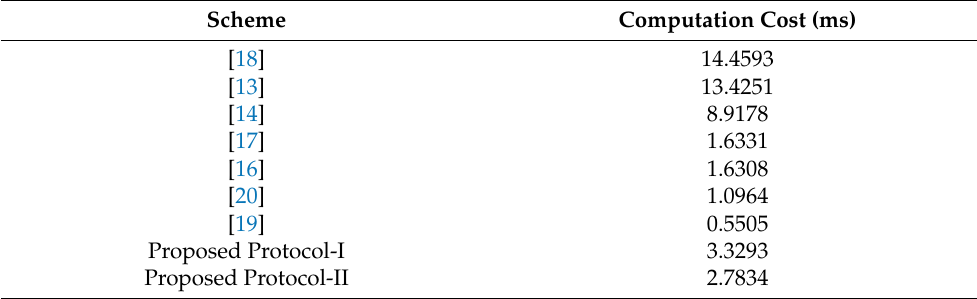
Table 3. Computation cost